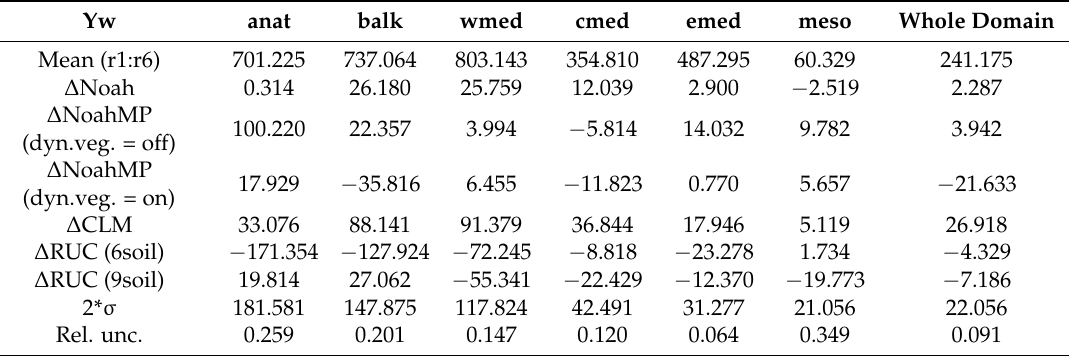
Table 4. Mean values of Yw for durum wheat derived from the six experiments, the difference ( ∆ ) of each run from the overall mean value, two times standard deviation and the “relative dispersion” for the six sub-domains (Anatolia, Balkans, western, central & eastern Mediterranean and Mesopotamia) and the reduced MENA domain. Yw anat balk wmed cmed emed meso Whole Domain Mean (r1:r6)